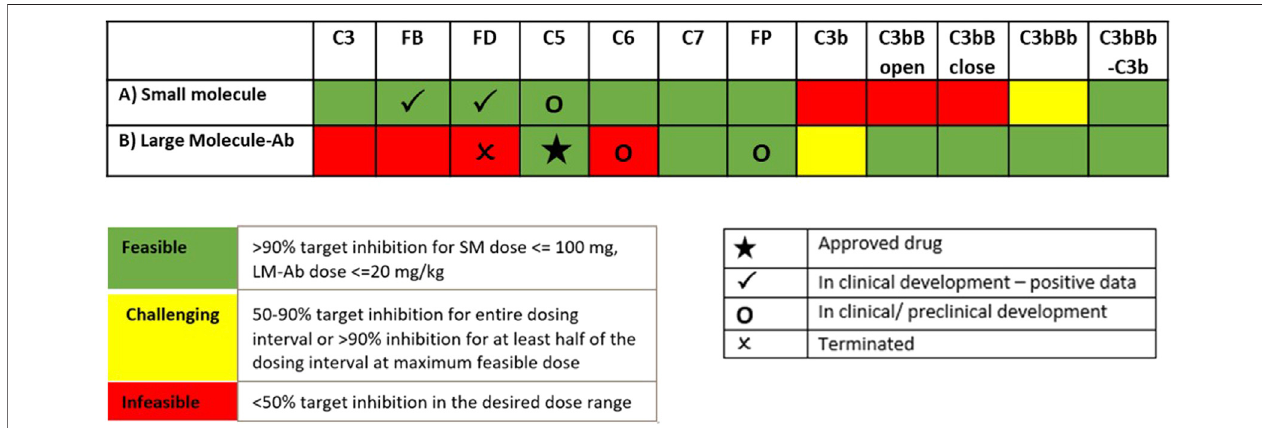
FIGURE 12 | Model predictions for dosing tractability of complement proteins for SM and LM-Ab drugs.